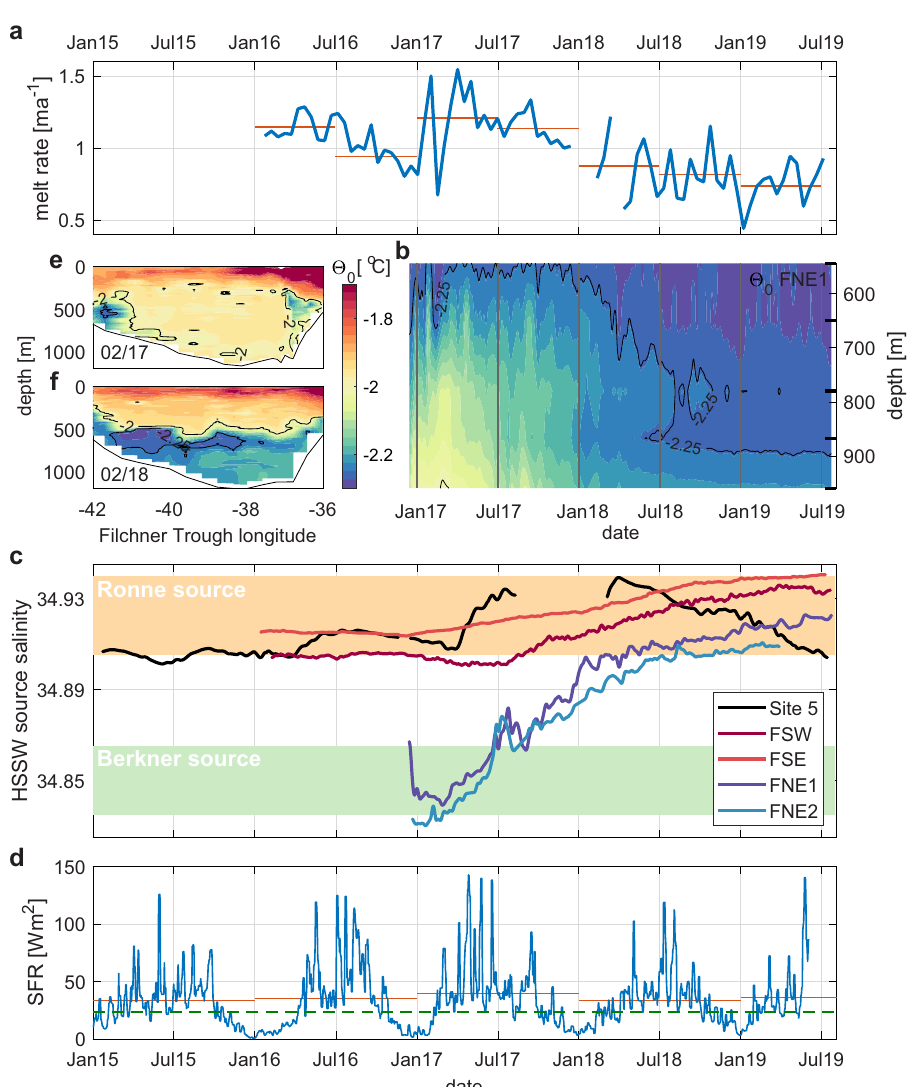
Fig. 2 Indicators of a mode shift beneath Filchner Ice Shelf. Time series of ( a ) ice shelf basal melt rates near FNE1, and ( b ) ocean conservative temperature at FNE1. c Source water salinities observed at each ice shelf mooring, indicating the Ronne (orange) and Berkner (green) HSSW regimes, and ( d ) 15-day low-pass fi ltered daily SFRs in front of Ronne Ice Shelf in comparison with the long-term average (green dashed line). e , f CTD sections of ocean conservative temperature at locations indicated in Fig. 1a along the Filchner Ice Shelf front for February 2017/2018. Thick black ticks along the y- axis in ( b ) indicate the depth of the temperature sensors at FNE1. Black − 2.00 °C and − 2.25°C temperature contours in ( a , e , & f ) delineate the presence of ISW. Red horizontal lines in ( a ) and ( d ) show time-averaged values over shorter periods of each time